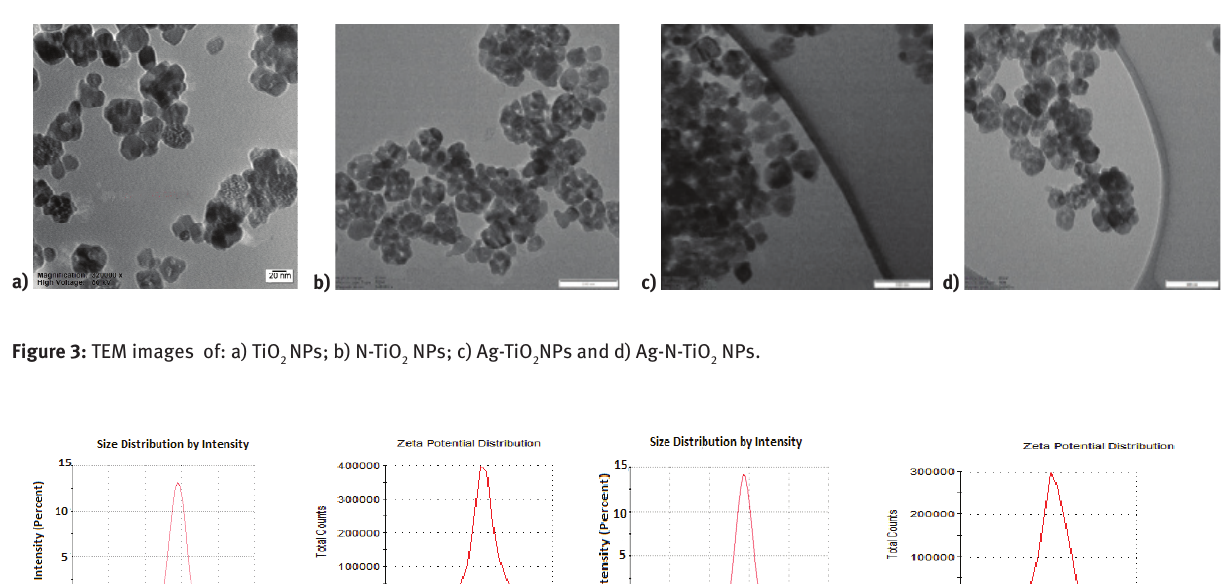
NPs (a,b) and for Ag-N-TiO NPs (c,d) in aqueous dispersions. 2 2